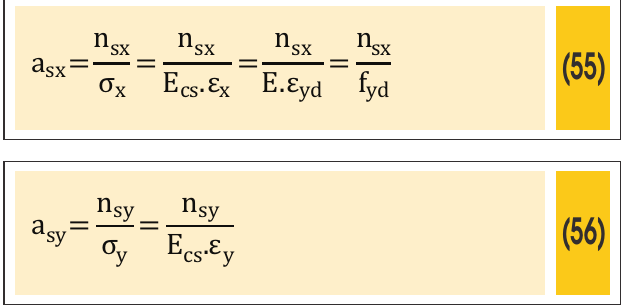
Table 2 – Maximums values for